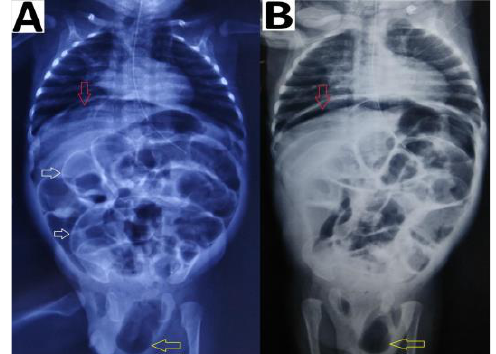
Figure 3: Abdominal radiographs (erect) (A) showing gas under the diaphragm (red arrow), Rigler sign (white arrows); supine image (B) showing pneumoperitoneum (red arrow) and pneumoscrotum (yel- low arrow) C-reactive protein (CRP) was done in 2 patients and was raised in both. In the other two, CRP could not be performed due to resource limitations.